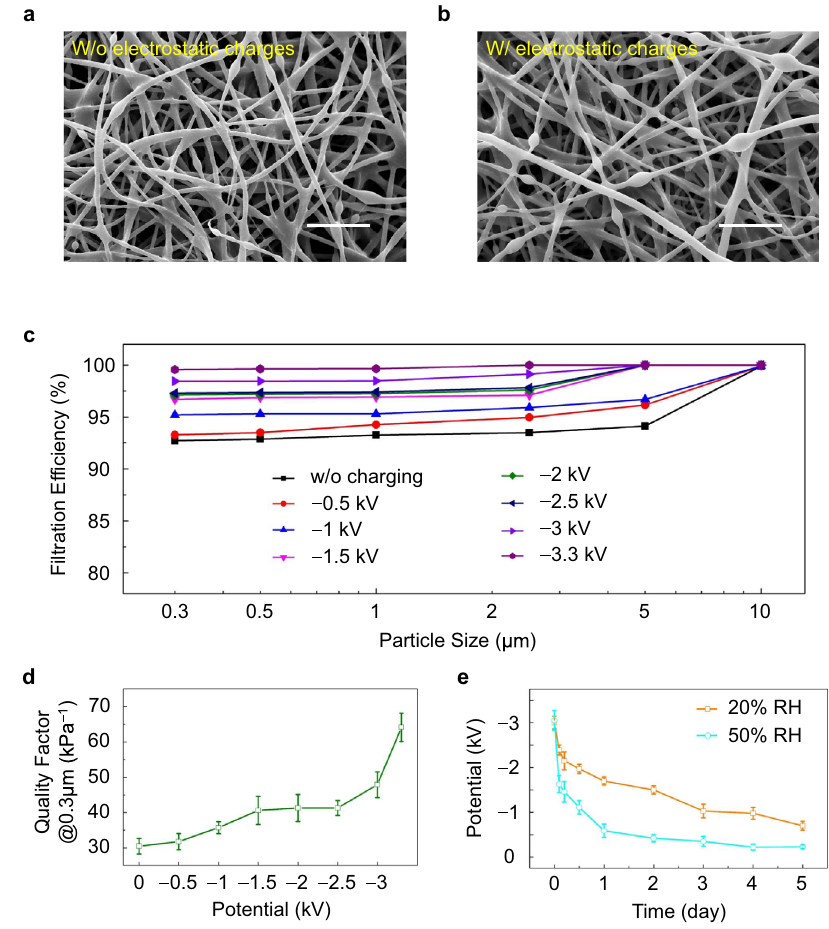
d Potential-dependent quality factor for 0.3- μ m particles. e Electrostatic potential attenuation under 20% and 50% relative humidity. Data are presented as the mean values±standarddeviations( n =5independentsamples).Sourcedataareprovided as a Source Data fi